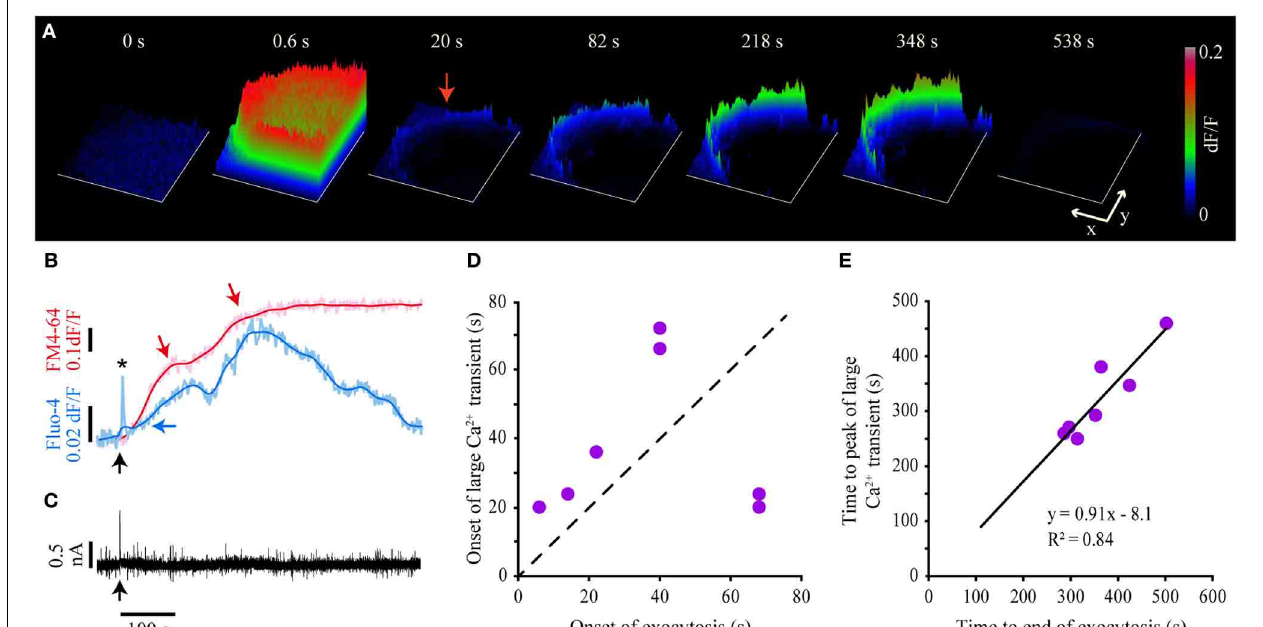
FIGURE 4 | Kinetics of the large Ca 2 + transient and exocytosis. (A) Sequence of surface plots of the Fluo-4 fluorescence in response to a 20-Hz train. The onset of the train was at t = 0. The frame at 0.6s shows the peak of the fast Ca 2 + transient; the frame at 20s shows the small Ca 2 + transient, and the subsequent frames show the development of the large Ca 2 + transient. Note that the fluorescence increases were limited to the submembrane region of the soma. The x and y scale bars = 10 µ m. The z-axis indicates the relative (dF/F) fluorescence levels as calibrated on the right bar. (B) Kinetics of simultaneously acquired FM4-64 (pink) and Fluo-4 (pale blue) confocal fluorescence following 20-Hz stimulation. The black arrow indicates the onset of the 20-Hz train. The kinetics of exocytosis had two sigmoidal components, each pointed by a red arrow. The smoothed kinetics (red and blue) are superimposed to each trace. The amplitude of the fast Ca 2 + transient (asterisk) is